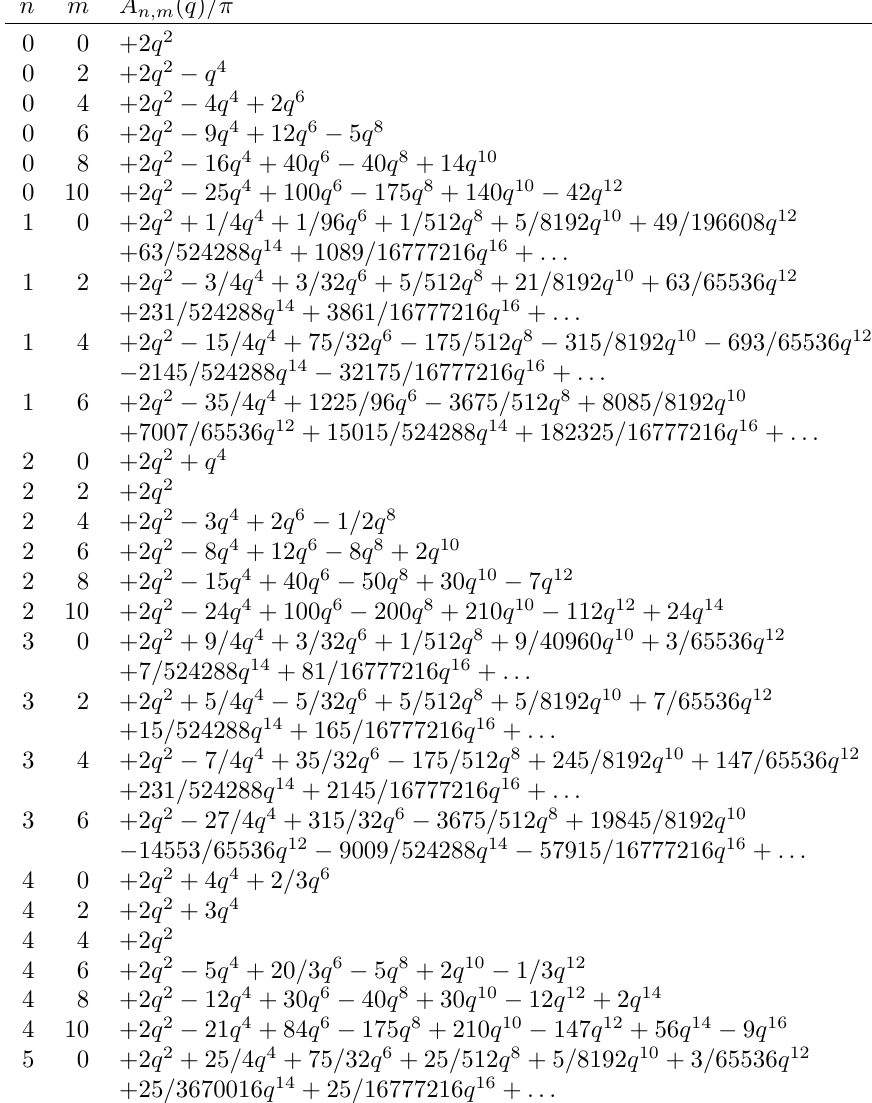
Table 1. Examples of series expansions of A n,m ( q ) /π . These are polynomials in q 2 if n − m is even, else shown as truncated power